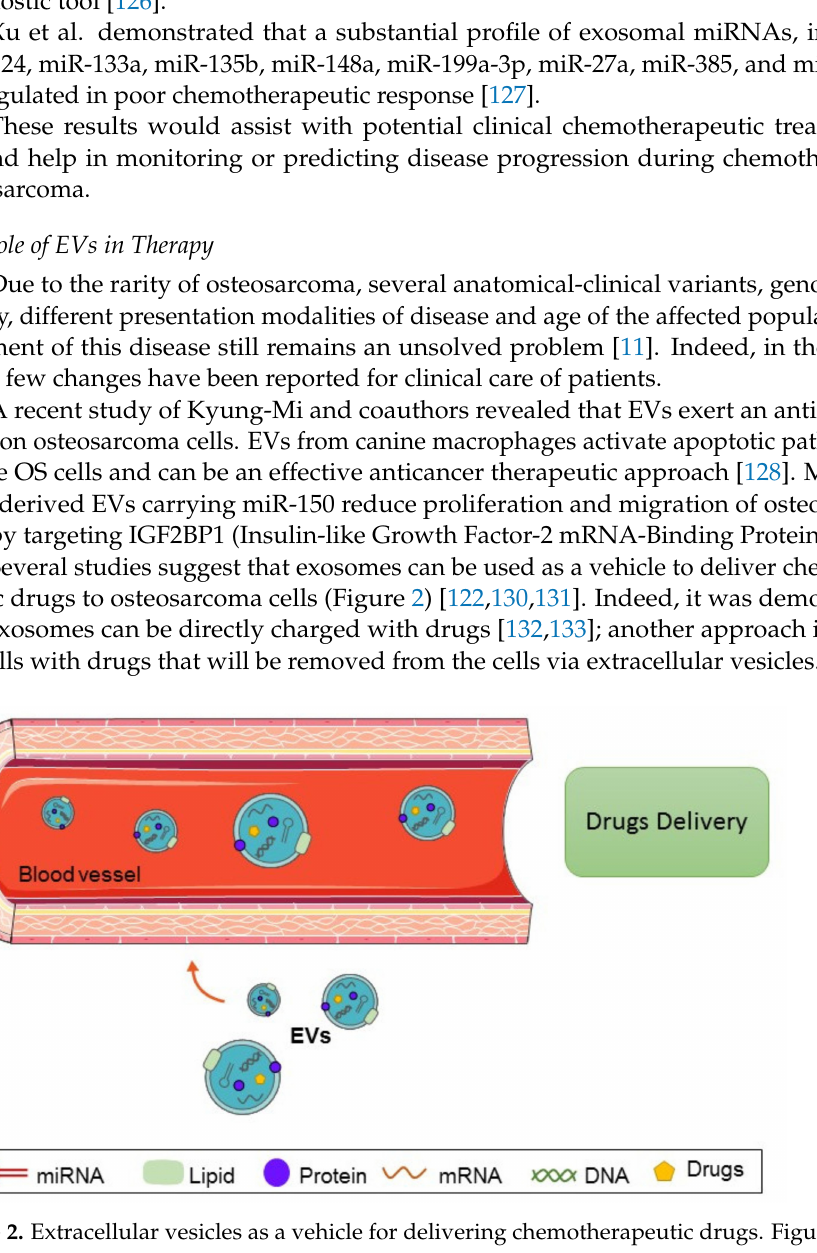
Figure 2. Extracellular vesicles as a vehicle for delivering chemotherapeutic drugs. Figure created using Servier Medical Art (https://smart.servier.com; accessed on 1 October